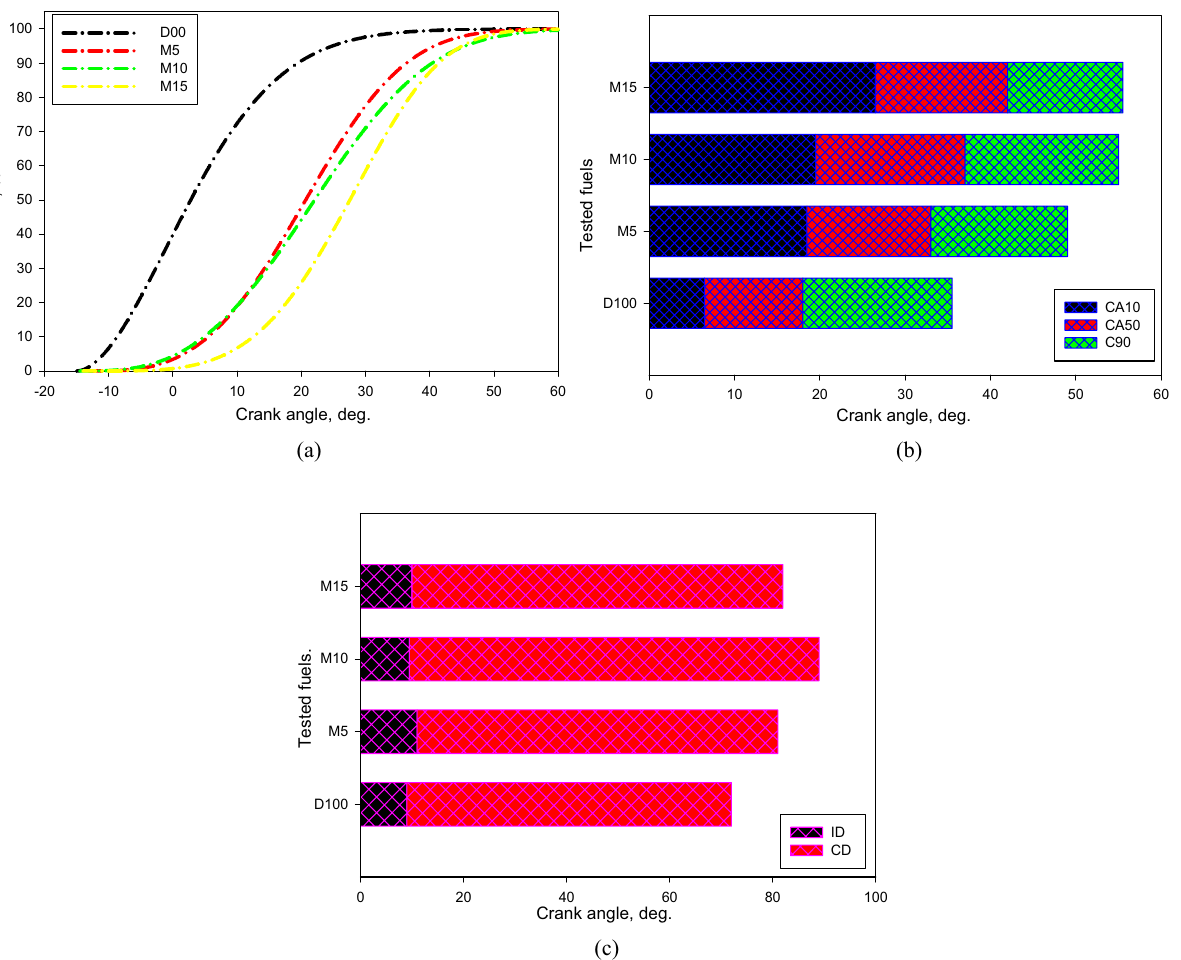
Figure 6. Discrepancy of X b , CA10, CA50, CA90, ID, and CD via crank angle for tested fuels at bmep of 4.5